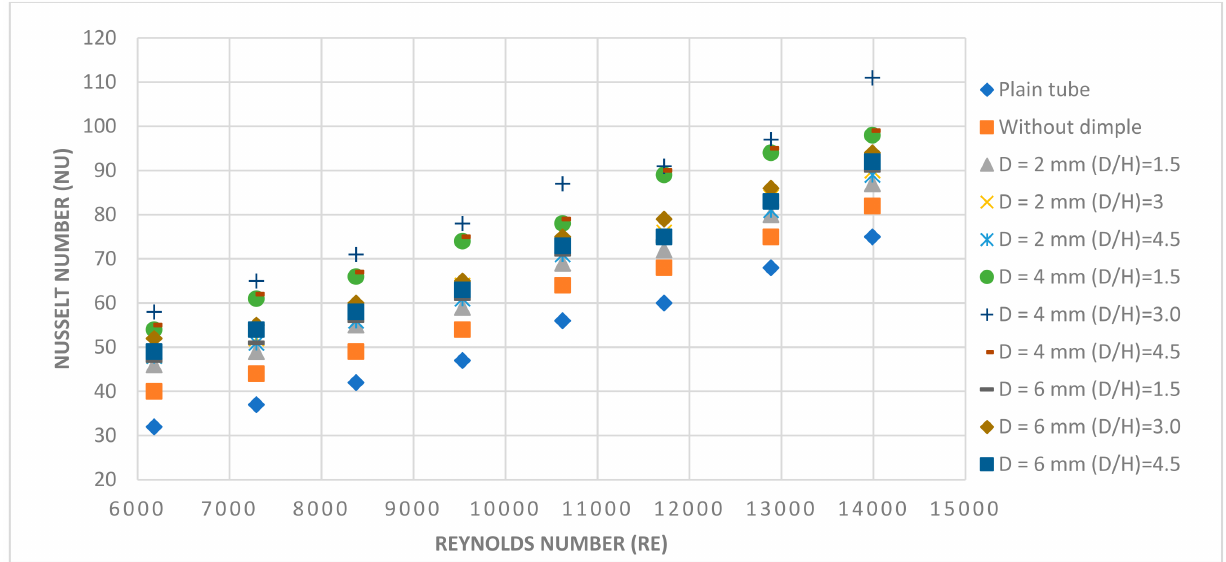
Figure 11. Experimental validation of Nusselt number Vs Reynolds number at various values of D/H ratio’s (1.5, 3 and 4.5) and different Dimple Diameter (2, 4 and 6 mm).